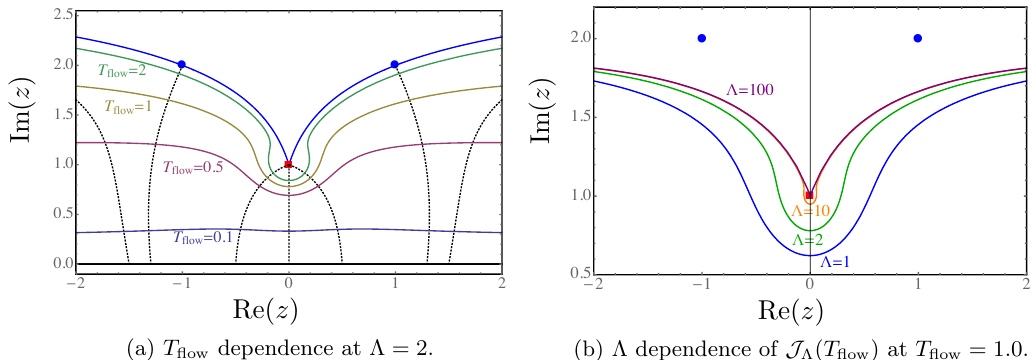
Figure 4 . Complex contours J (cid:3) ( T (cid:13)ow ) for the Gaussian model with the fermion determinant with p = 2, (cid:11) = 2, and (cid:12) = 3 (Case 1). The black dashed curves (left (cid:12)gure) show (cid:13)ow lines with initial condition at the intersection with the real axis. The zero of the \fermion determinant" is denoted by the red square while the blue dots shows the saddle points which are intersected by the Lefschetz thimble in the left